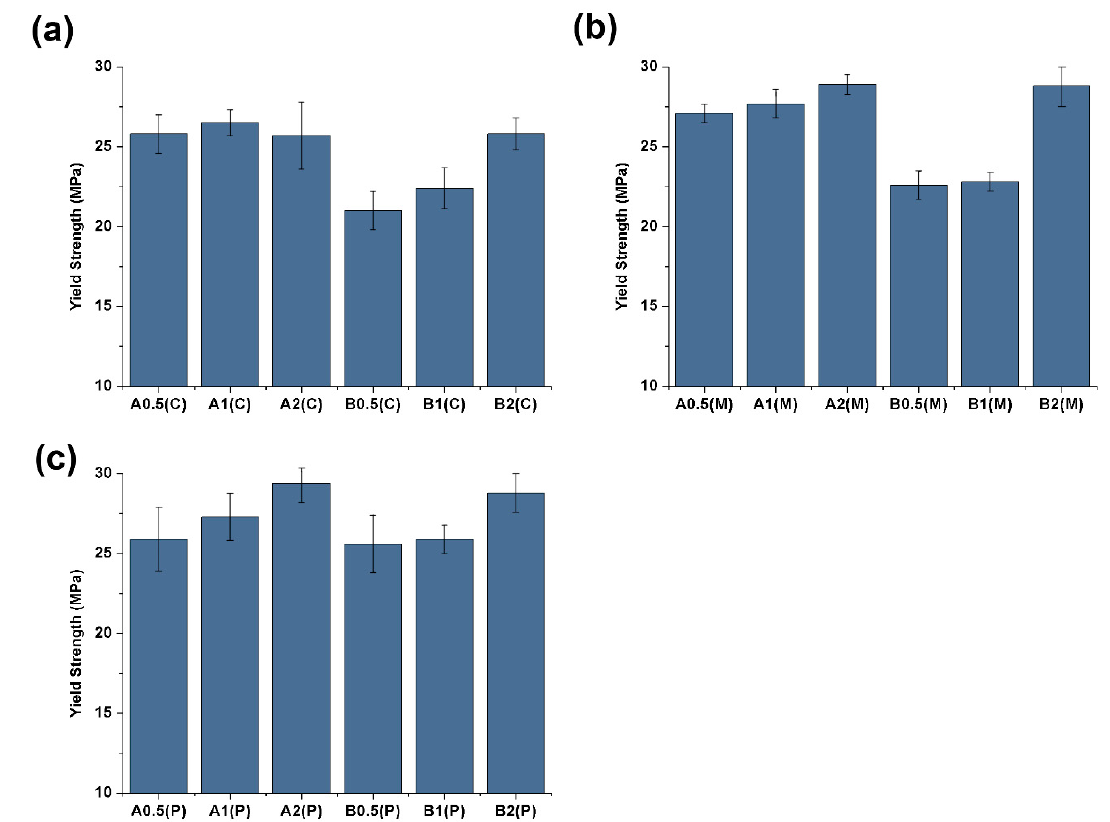
Figure 4. Yield strength of ( a ) CIM, ( b ) MFVIM, and ( c ) PVIM.